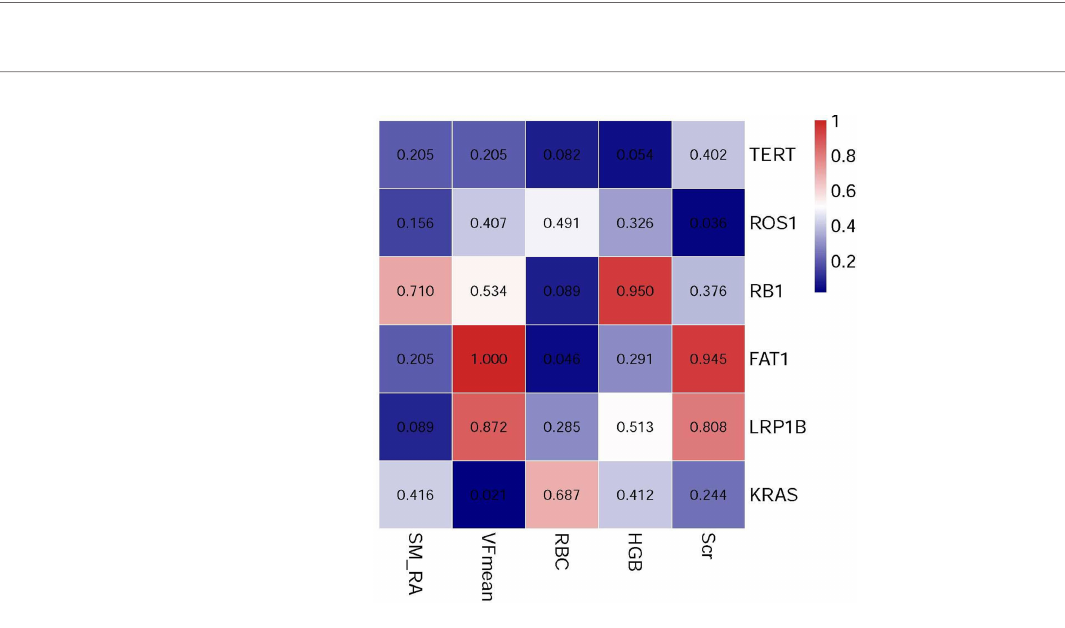
FIGURE 7 | The heat map illustrates associations between the genetic mutation and selected body composition features and clinical